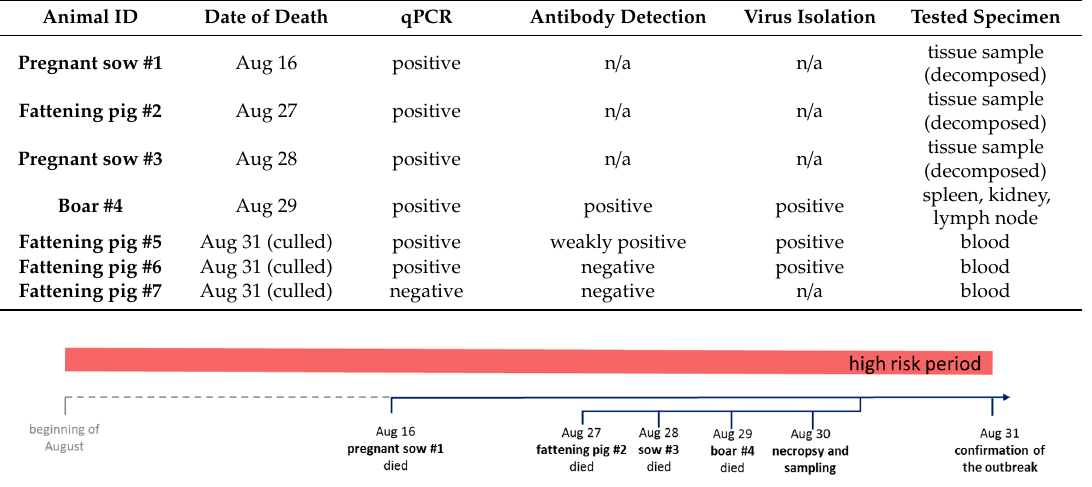
Figure 3. Timeline of the outbreak and estimated high-risk period.